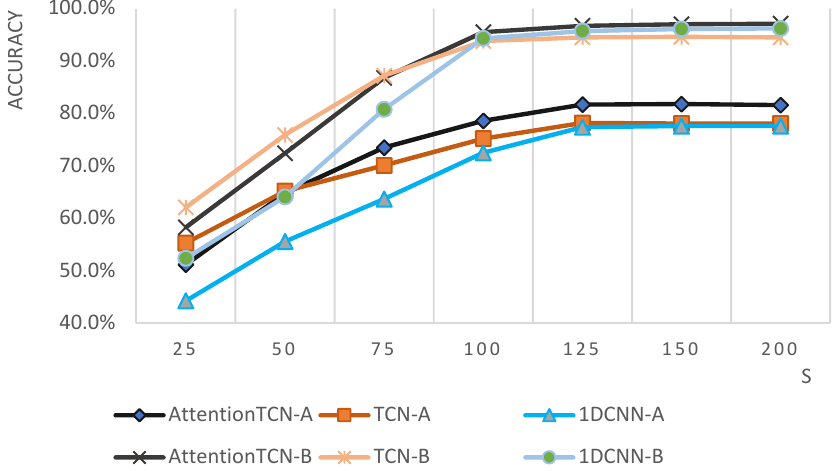
Figure 8. The test accuracy of the network for different s values.